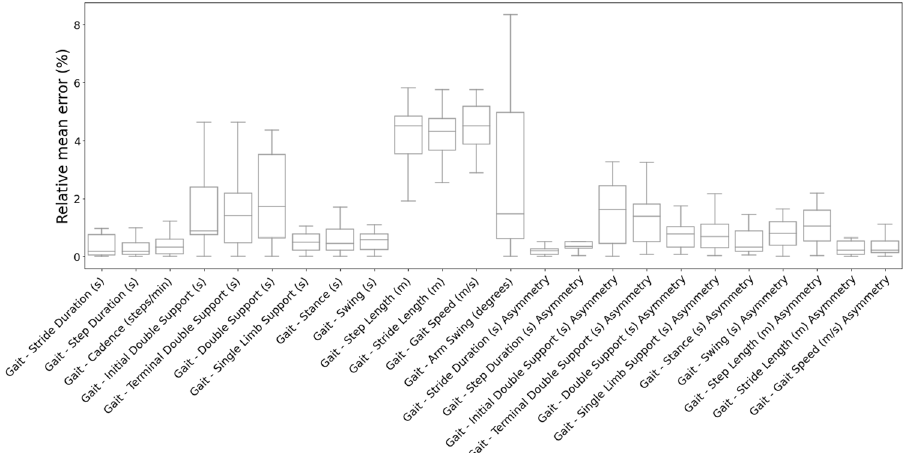
Fig. 5 Variability of Gait Features. Distribution of the relative mean error across 50, 100 and 128 Hz sampling rates per calculated feature. The solid line represents the median value; the box limits show the interquartile range (IQR) from the fi rst (Q1) to third (Q3) quartiles; the whiskers extend to the furthest data point within Q1 – 1.5*IQR (bottom) and Q3 + 1.5*IQR